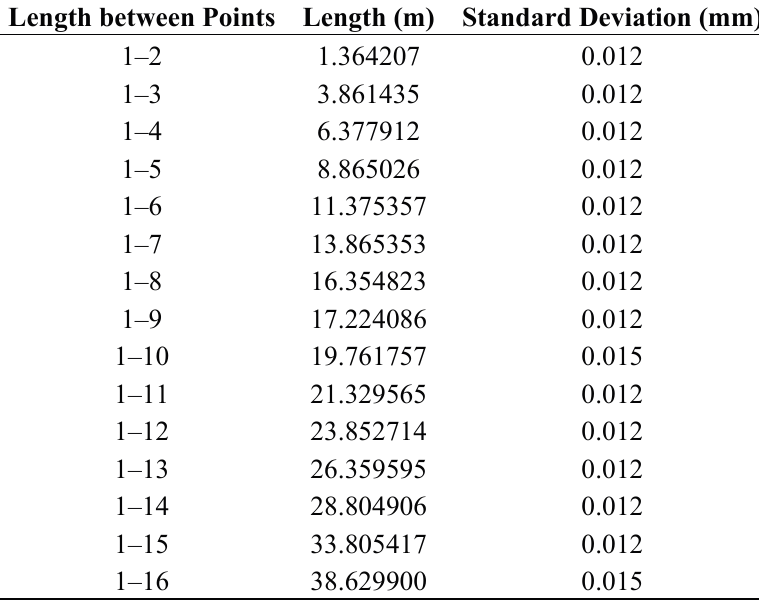
Table 1. Length of laboratory pillar baseline